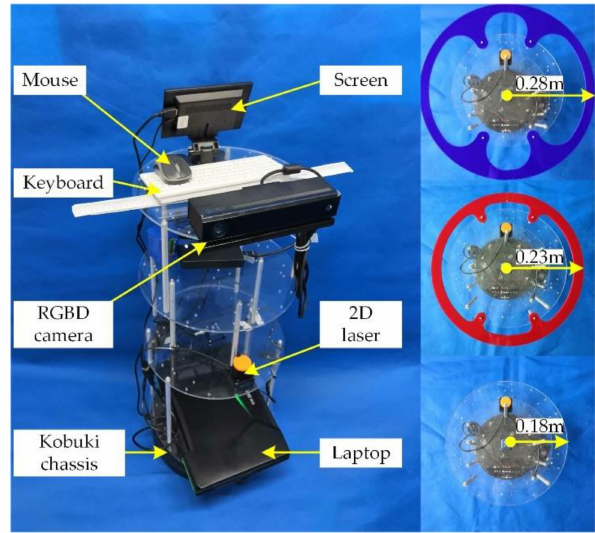
Figure7. Robotplatform: thethreelengthsintherightcolumnmeansdi ff